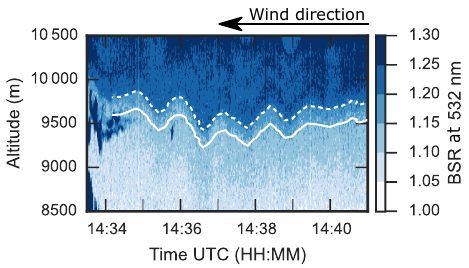
Figure 6. Close-up view of BSR data in the lee wave region south to the cirrus cloud. Dotted line: contour line (BSR = 1.2); solid line: trajectory used for simulation (contour line shifted by